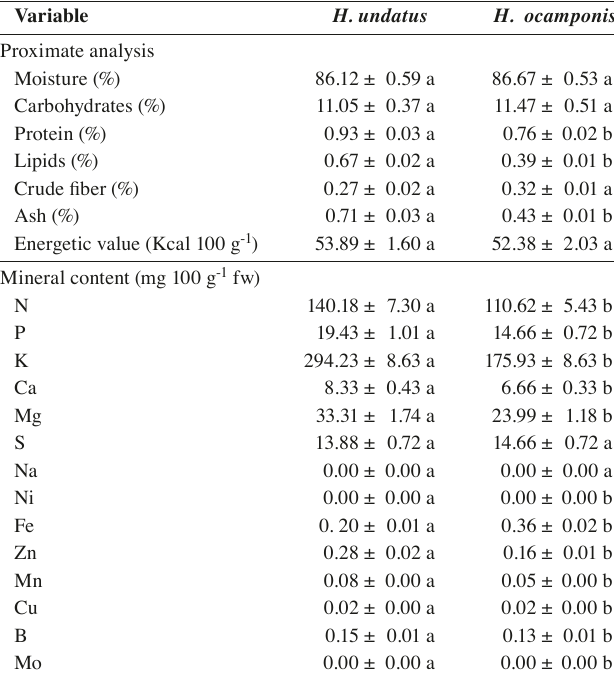
Tab. 2: Nutritional components in pitahaya fruits with white ( Hylocereus undatus ) and red pulp ( H. ocamponis ).